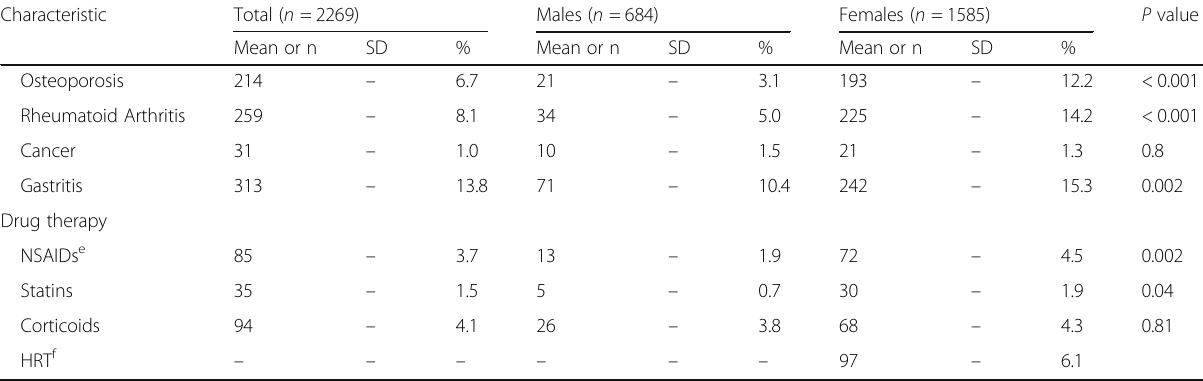
Table 1 Demographic and clinical characteristics of the participants – The Brazilian Osteoporosis Study (Continued)